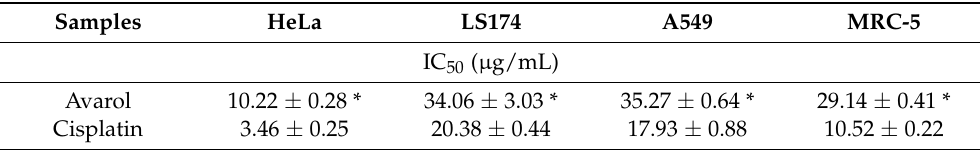
Table 1. Concentrations that induced 50% decreases in HeLa, LS174, A549, and MRC-5 cell survival rates. The samples were incubated with cells for 72